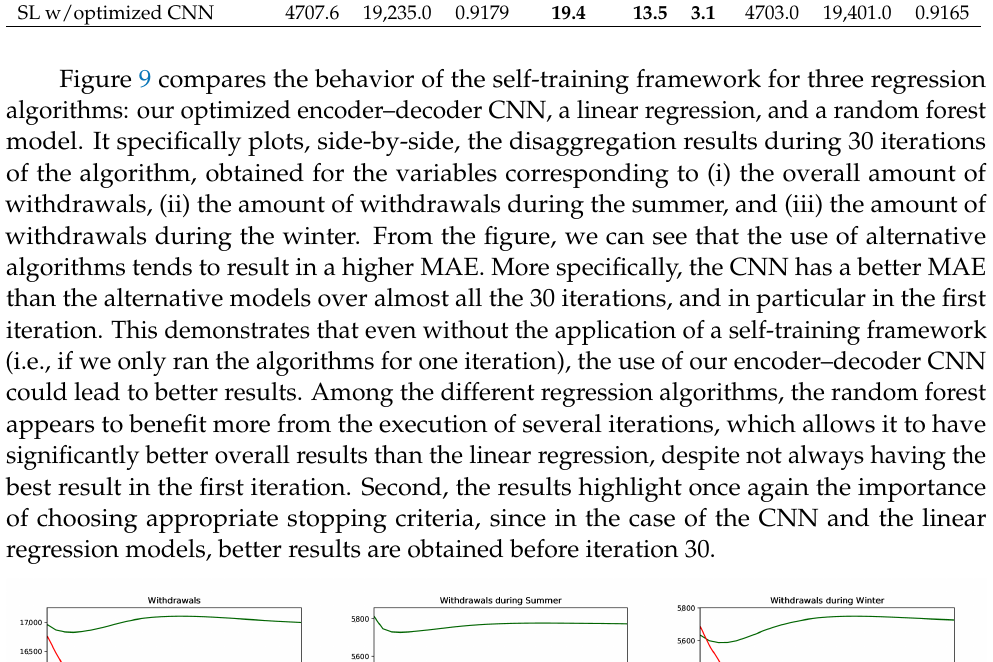
Table 11. Results obtained with the self-training approach using different regression algorithms for the amount of national withdrawals during the winter months. Gain(%) / Baseline W/o Stopping Criterion MAE RMSE R 2 MAE RMSE R 2 MAE RMSE R 2 Smooth weighted interpolation 5842.8 22,233.1 0.8904 — — SL w/linear model